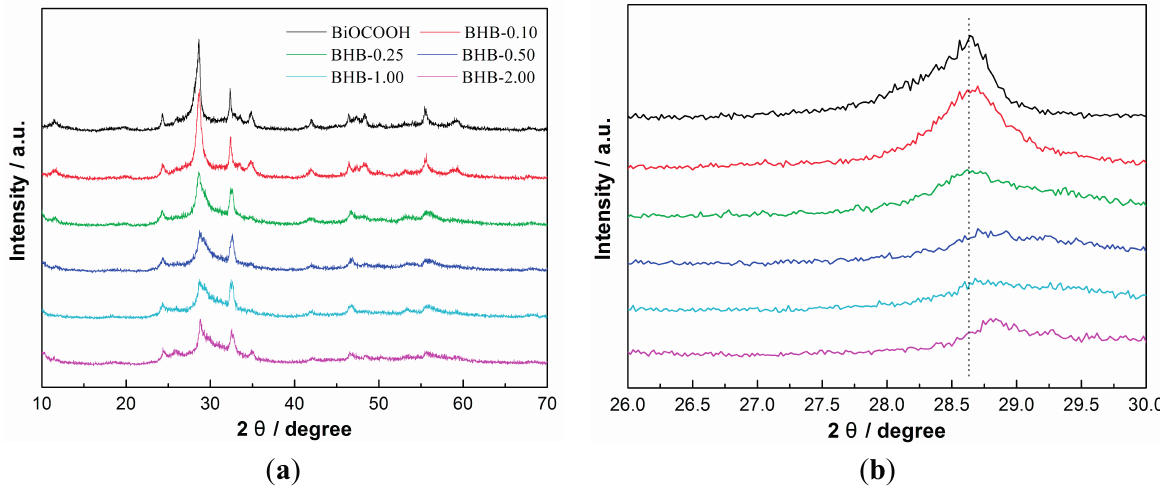
Figure 1. XRD patterns of as-prepared BiOCOOH and BHB with different Br contents ( a ) and the enlarge view ( b